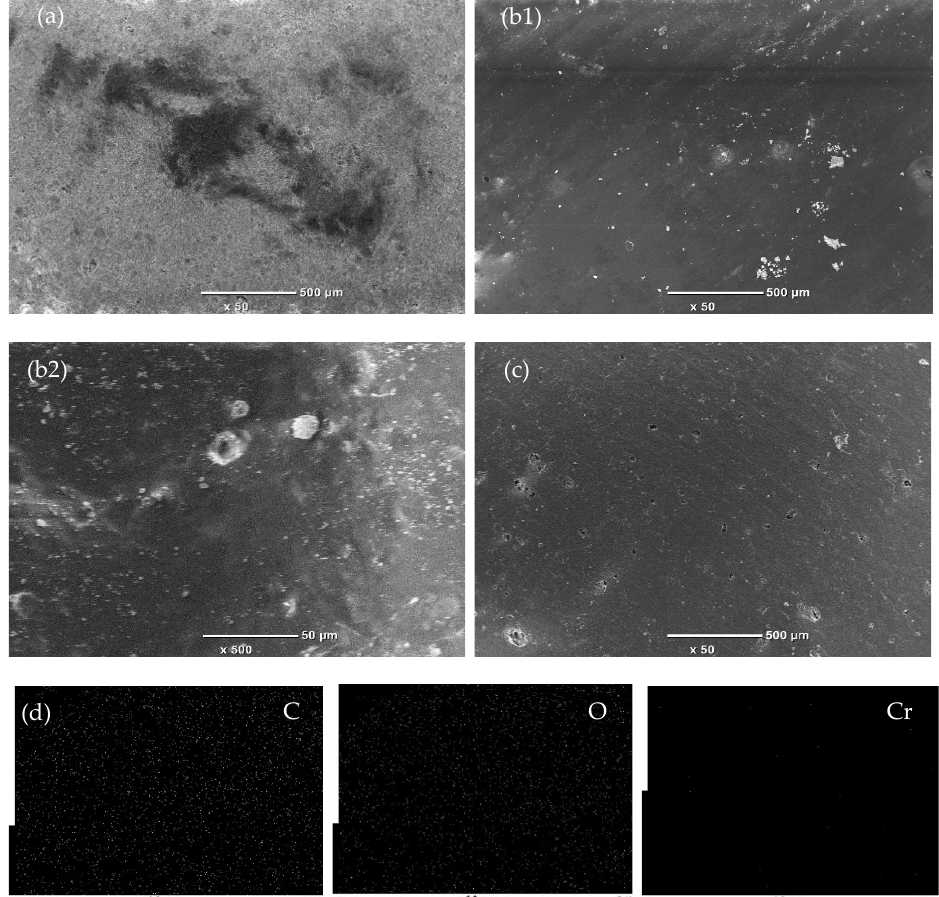
Figure 4. SEM images of the top surface of ceramic membrane before coating ( a ), after coating with crosslinked chitosan ( b1 , b2 ), and after ultrafine filtration of Cr(VI) ( c ), and mapping images of CCCM after ultrafine filtration of Cr(VI) ( d ).